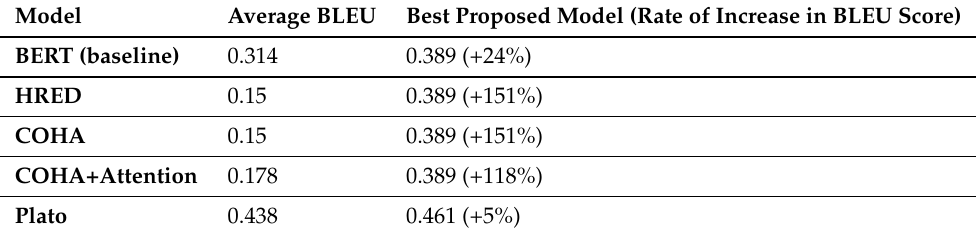
Table 5. Rate of increase in BLEU score compared to our best proposed model.